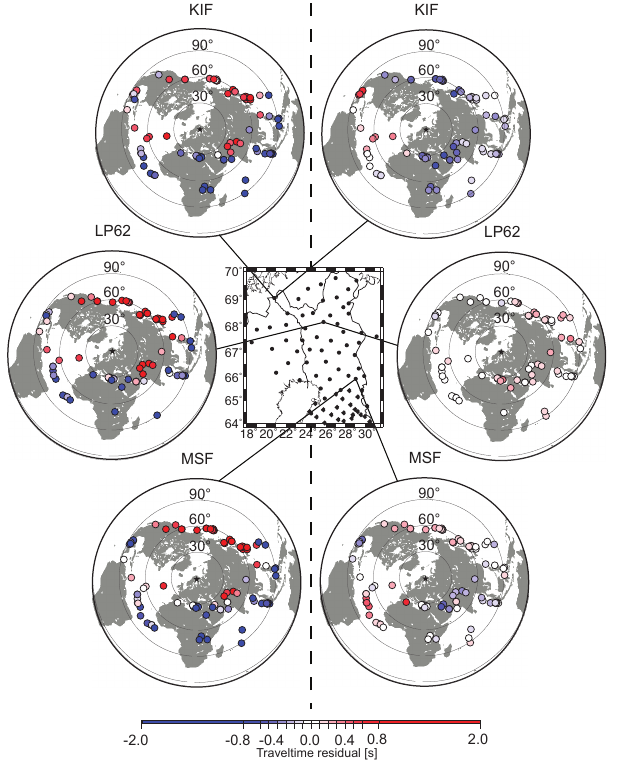
Figure 4. Distribution of travel time residuals relative to standard Earth model iasp91 (Kennett and Engdahl, 1991) at three example stations selected from different parts of the POLENET/LAPNET network. The observed absolute residuals are on the left-hand side and the relative residuals after the average over all stations for each event has been removed are on the right-hand